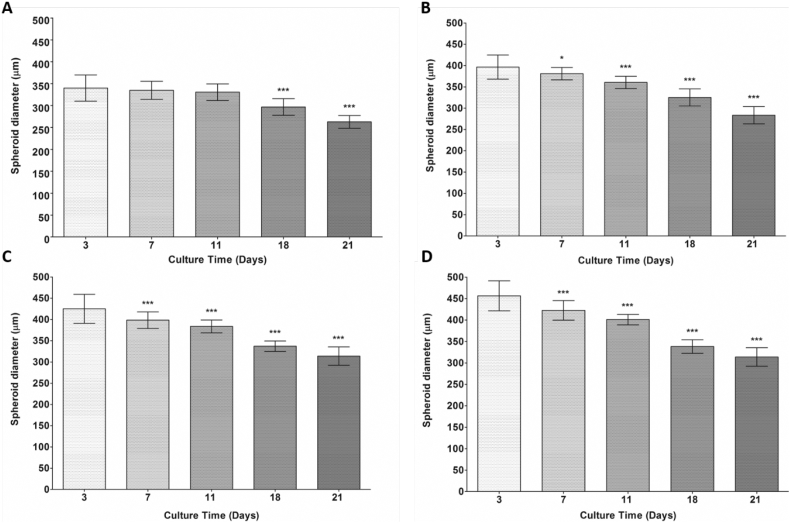
Statistical analysis of spheroid compaction.Statistical analysis of spheroid compaction over culture time. There was a time dependent decrease in spheroid diameter up to 21 days in culture. Fig. 3 (A) describes the decrease in spheroid diameter for 2000-cell spheroids, (B) for 3000-cell spheroids, (C) for 4000-cell spheroids and (D) for 5000-cell spheroids. For 2000-cell spheroids, days 18, and 21 were considered statistically significantly smaller when compared to day 3. All other spheroid diameters for 3000, 4000 and 5000-cell spheroids were considered statistically significantly smaller compared to day 3 spheroids, by One-way ANOVA *P value < .05 and ***P value < .001. Data are represented as mean ± SD.